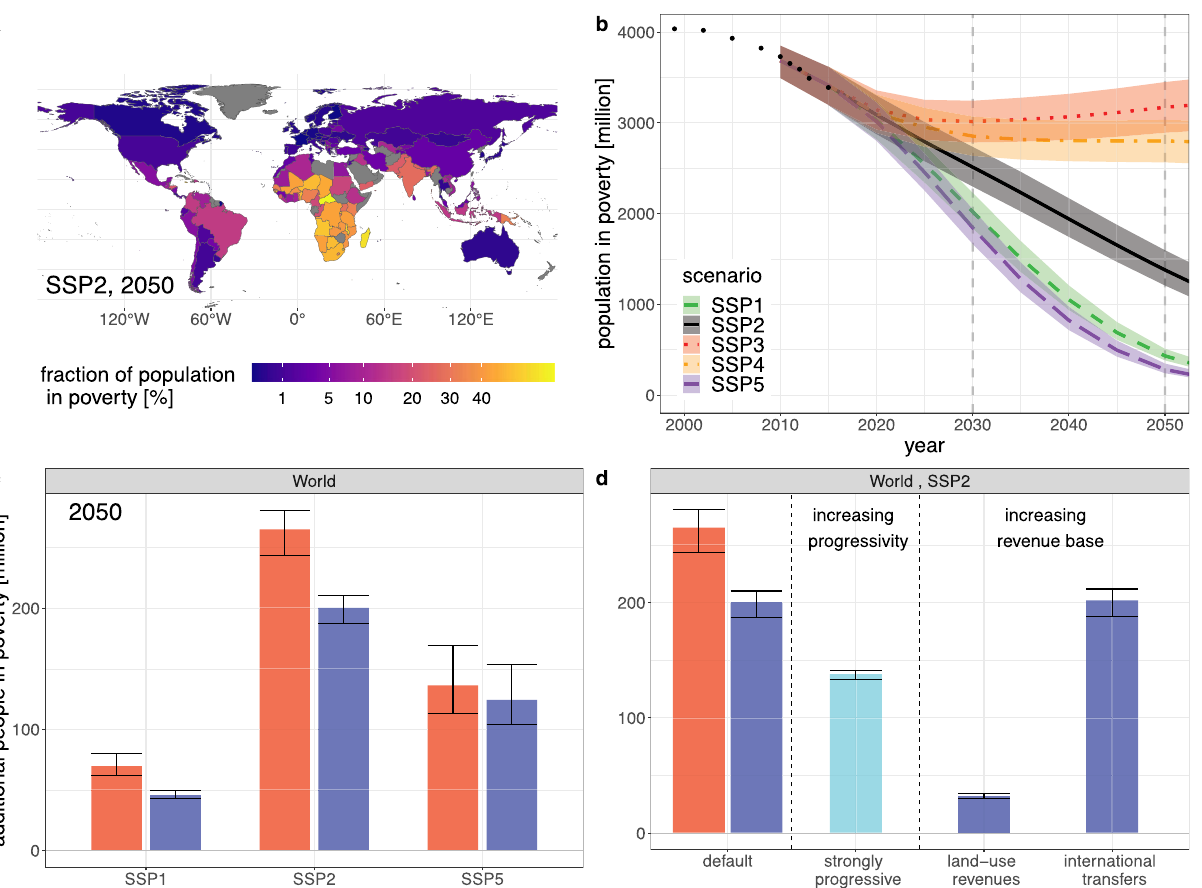
Fig. 6 Longer-term prospects for poverty eradication, using a higher poverty line of 5.50 $/day. a National poverty rates in 2050 (SSP2). b Global poverty trends (all SSP baselines). See the caption of Fig. 1b for a de fi nition of central estimate and uncertainty bands. c Longer-term effects of mitigation policies on poverty eradication (multiple SSPs, 2050). See Fig. 5 for the color legend and de fi nition of error bars of panels ( c and d ). d Effect of additional policies (SSP2,